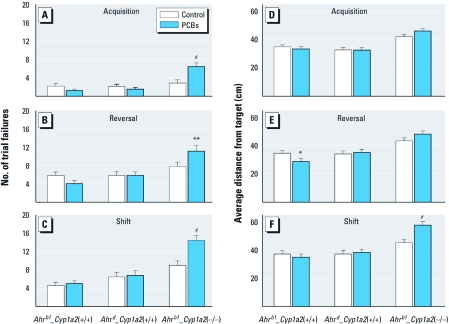
MWM trial failure (trials during which animals reached the time limit; A–C) and probe trials (average distance from the platform site 24 hr after the last platform trial of each phase; D–F). (A and D) Acquisition. (B and E) Reversal. (E and F) Shift. Values shown are (mean ± SE). *p < 0.05, **p < 0.01, and #p < 0.001 compared with control.